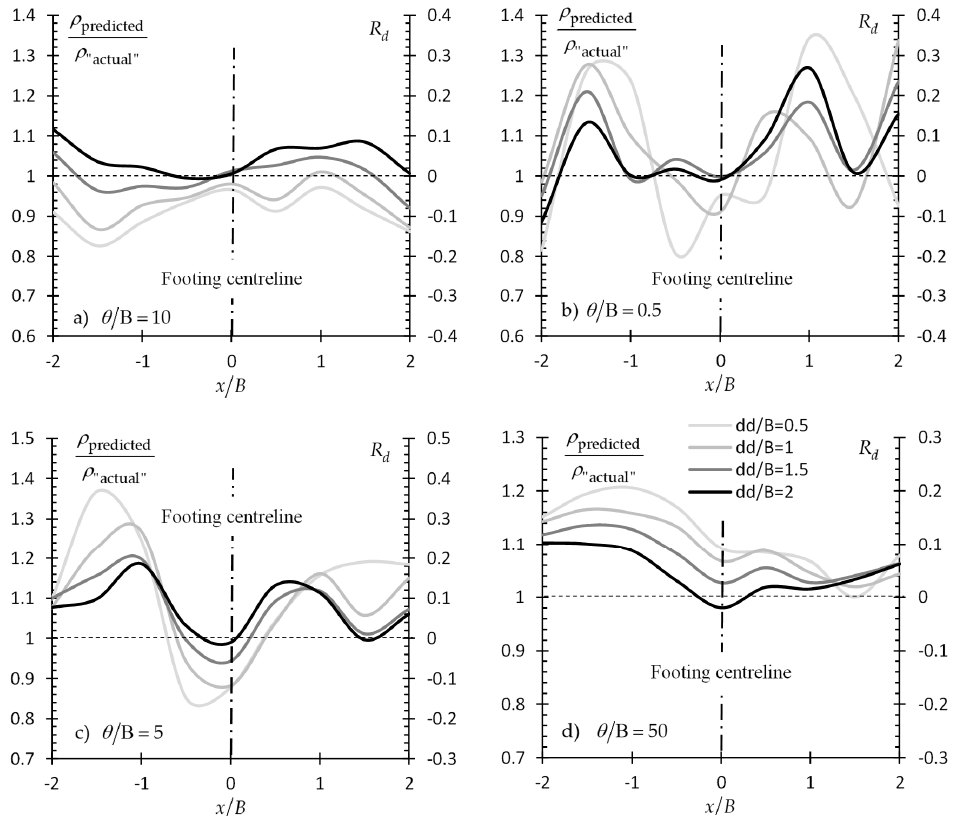
Figure 14. ρ predicted / ρ (cid:48)(cid:48) actual (cid:48)(cid:48) vs. x / B curves for various d d / B values for Example #1 ( a ), #2 ( b ), #3 ( c ) and #4 ( d ). The random elastic modulus fields of Examples #1, #2, #3 and #4 are presented graphically in Figures 1 and 11–13 respectively; see also Table 1.